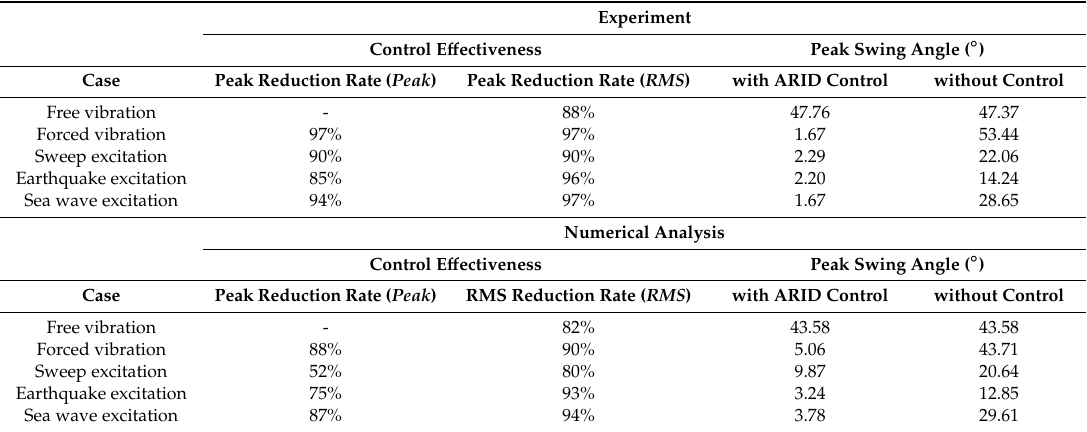
Table 4. Control e ff ectiveness comparison of the ARID